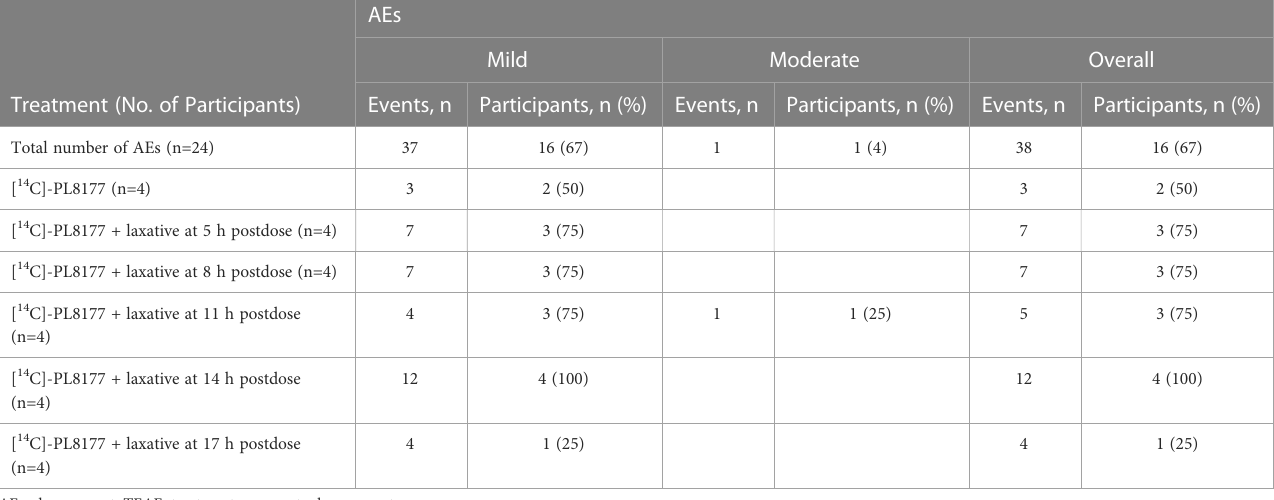
Treatment (No. of